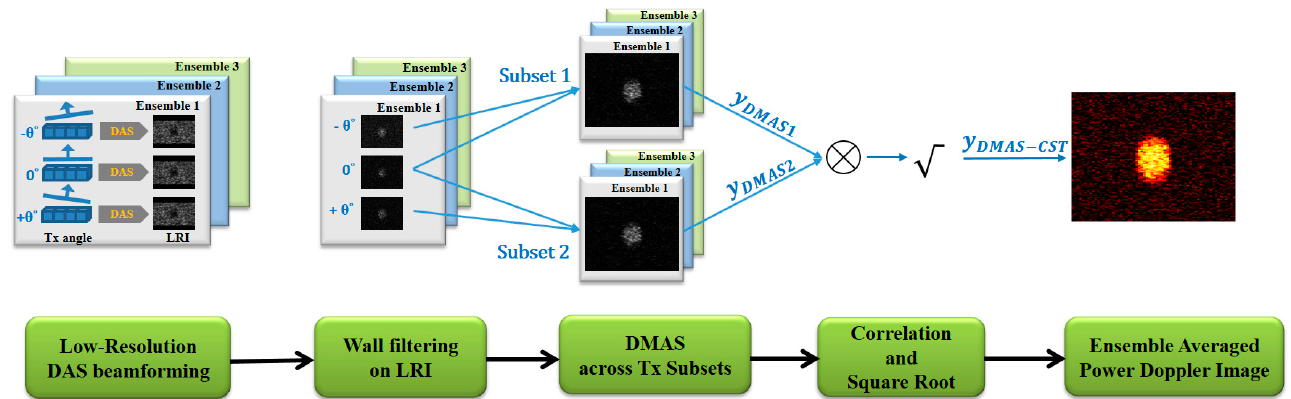
Figure 1. Schematic diagram of DMAS-CST beamforming for power Doppler detection in multi-angle PW imaging. Note that the wall filtering is performed on low-resolution images of each PW transmit angle before DMAS beamforming.